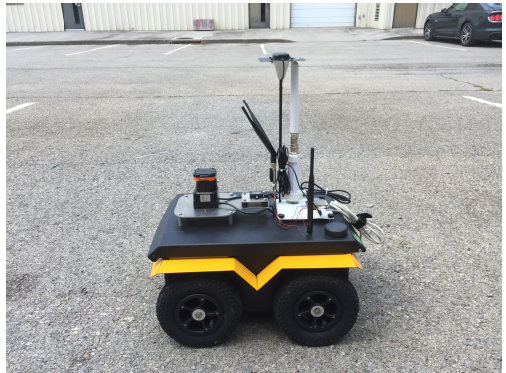
Figure 1. The Jackal unmanned ground vehicle shown with the first-generation Swifnav Piksi real-time kinematic global positioning system (RTK GPS)